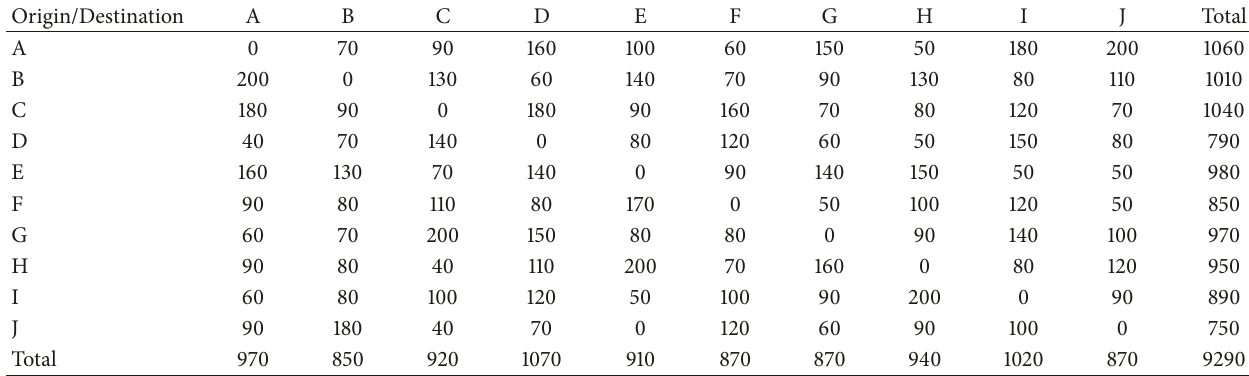
Table 1: Demands between origins and destinations (unit: veh/h).